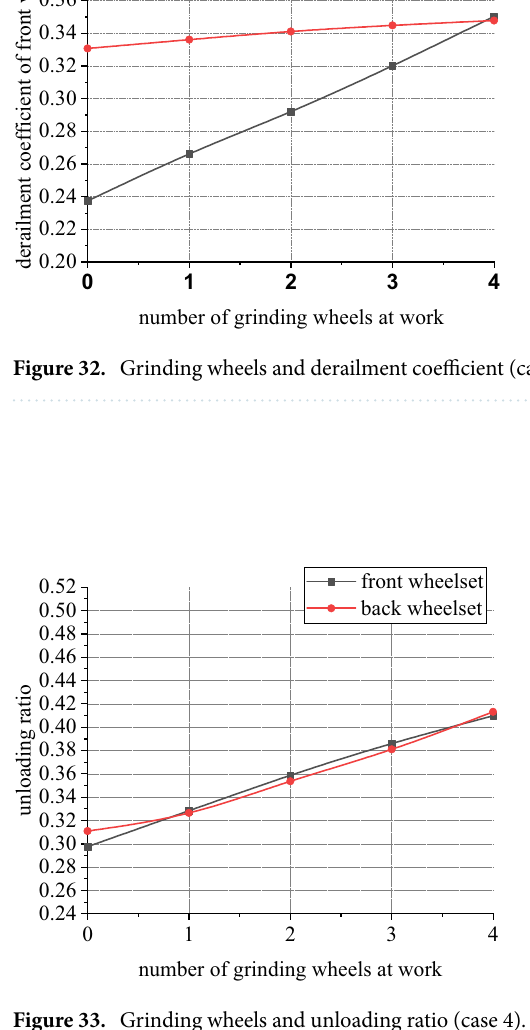
Figure 33. Grinding wheels and unloading ratio (case